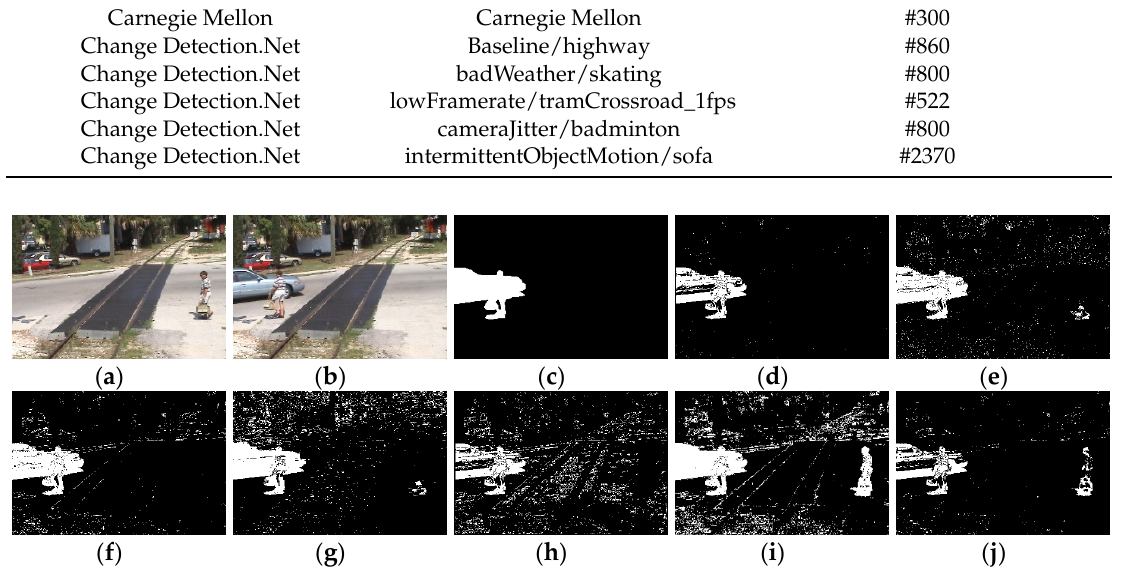
Figure 7. Comparison of segmentation results of seven background subtraction methods for one frame taken from the Carnegie Mellon sequence. ( a ) Frame n (start image), ( b ) frame n + 99, ( c ) ground ‐ truth, ( d ) entropy ‐ based initial background extraction (EBBE) (proposed), ( e ) codebook, ( f ) Gaussian mixture model (GMM), ( g ) kernel density estimation (KDE), ( h ) probability ‐ based background extraction algorithm (PBBE), ( i ) self ‐ organizing background subtraction (SOBS), and ( j ) ViBe.